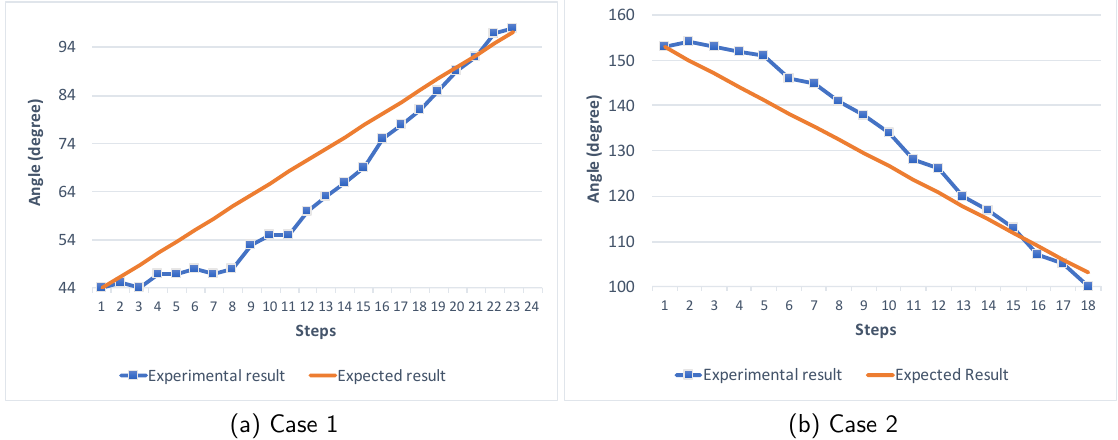
Figure 7. Angle convergence of the scooter steering